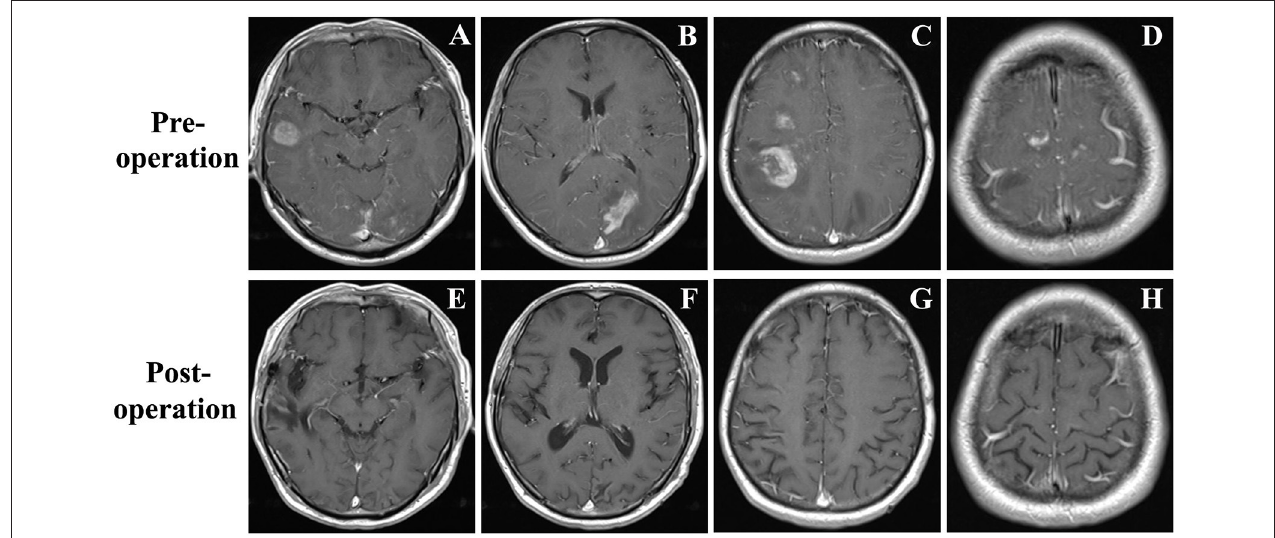
FIGURE 1 | (A–D) Brain MRI demonstrated a few contrast-enhancing, cotton-like lesions up to 25mm in diameter located in the right temporal, frontal, and parietal lobes, and left occipital lobe with perifocal edema. (E–H) Brain MRI revealed all the lesions disappeared at the fifth month of follow-up.